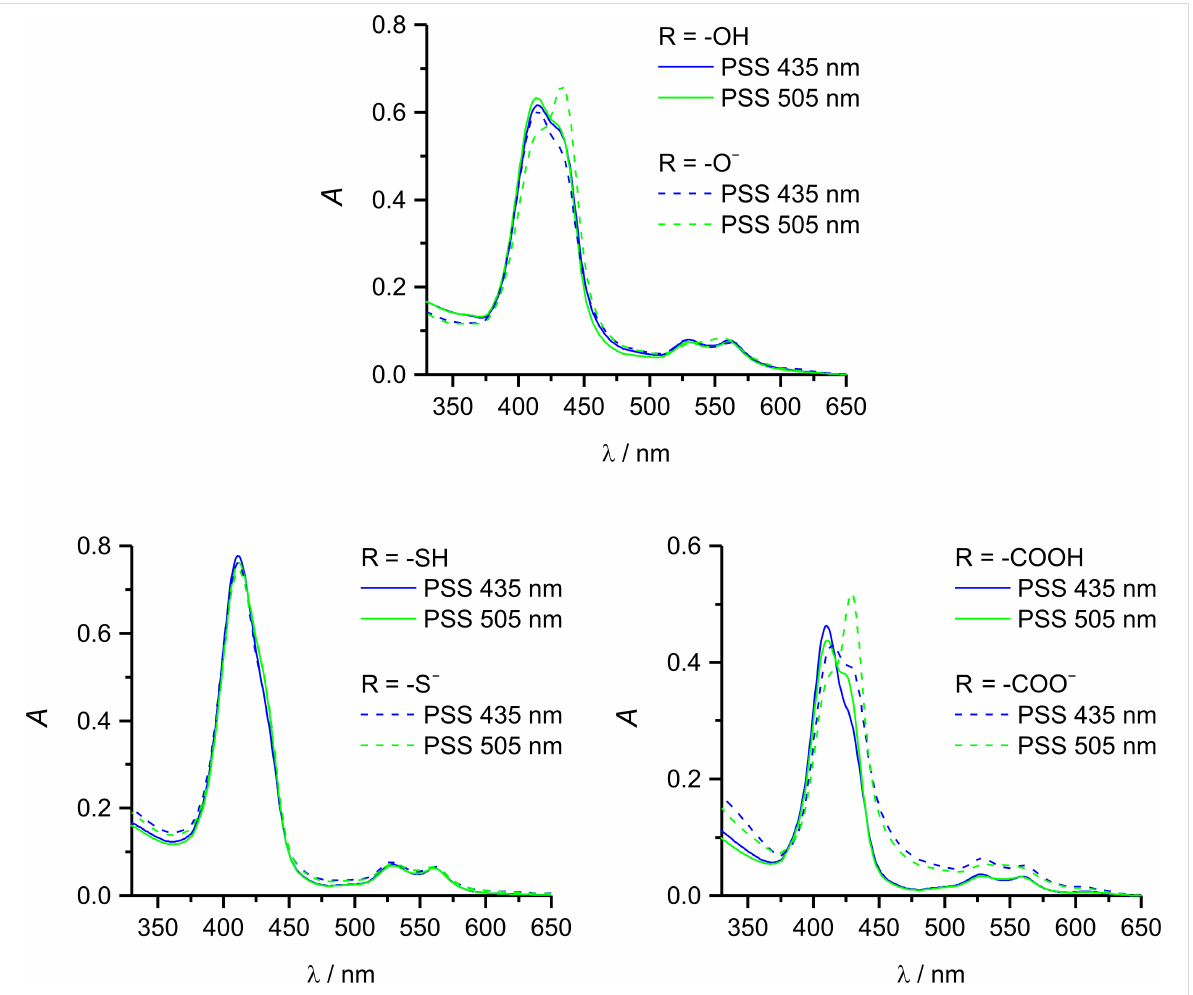
Figure 3: UV–vis spectra of 1e (top), 1h (left) and 1j (right) in acetone water (1:9) (solid line) and after deprotonation using cesium carbonate (dashed line) in the PSS at 505 nm (green) and 435 nm (blue).